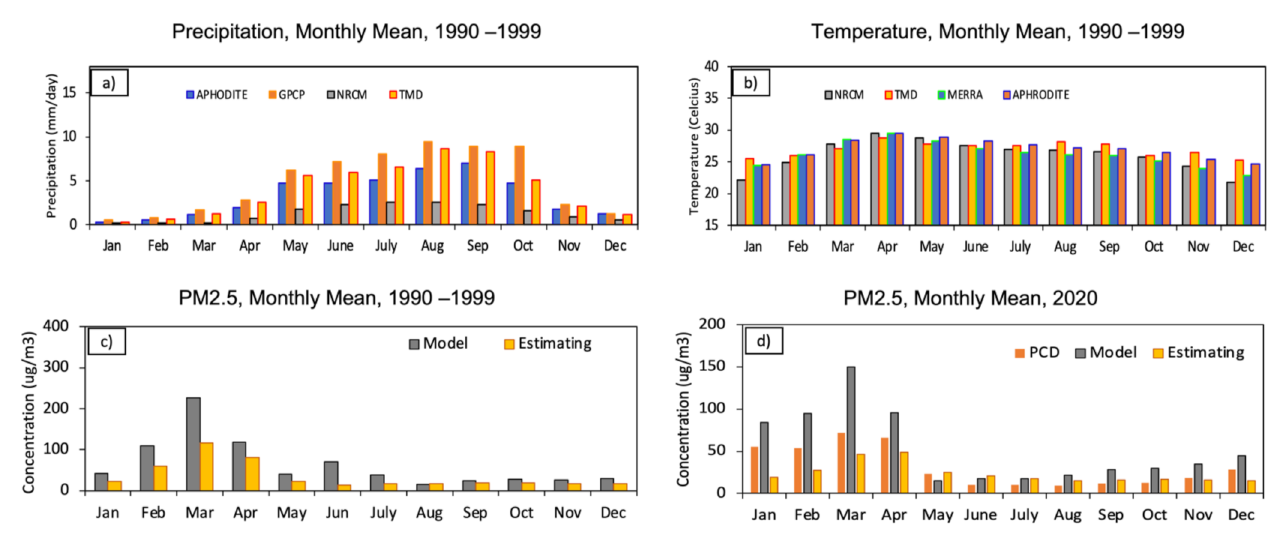
Figure 3. Monthly mean, ( a ) precipitation (mm/day), ( b ) temperature ( ◦ C), ( c ) PM 2.5 concentration averaged over 1990–1999 based on eight station location of TMD, and ( d ) PM 2.5 concentration in year 2020 based on three stations location of PCD in northern